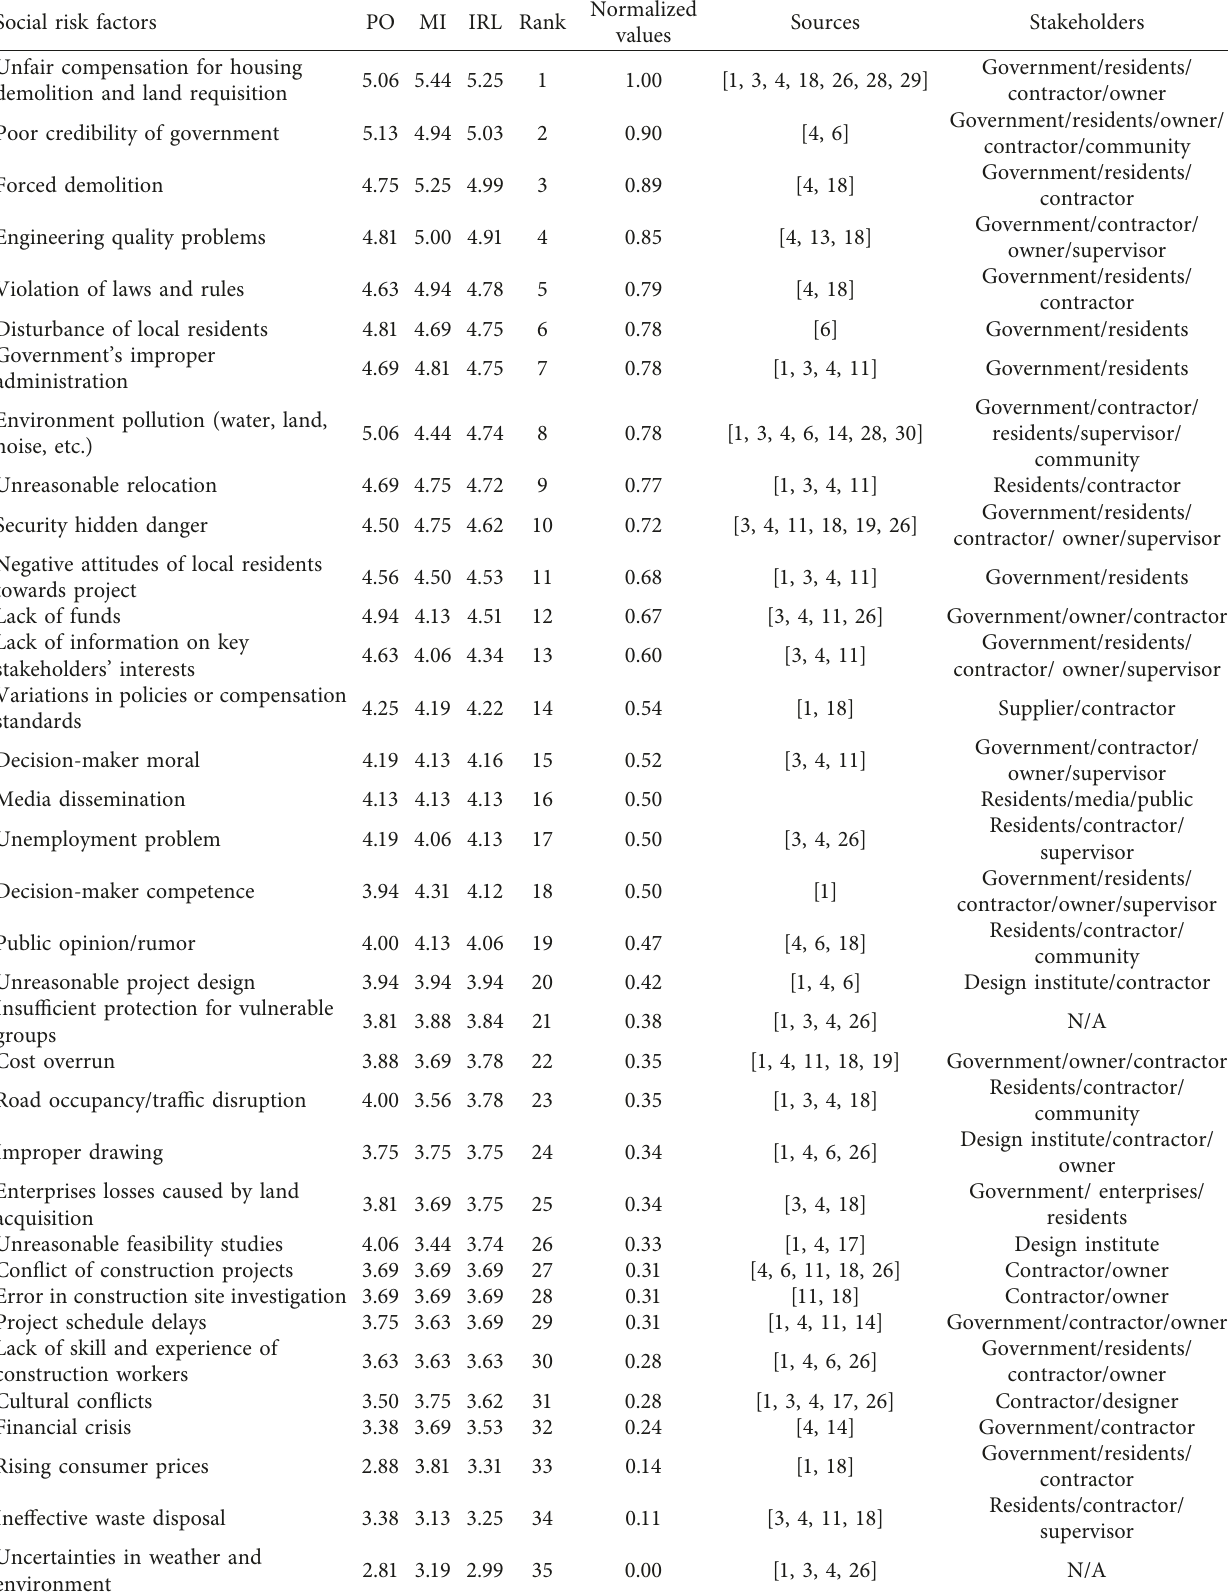
Table 2: Ranking of social risk factors based on the questionnaire